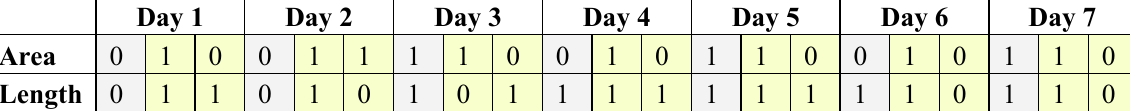
Table 3. Binary pattern of Opuntia cladodes for accumulated area and length.